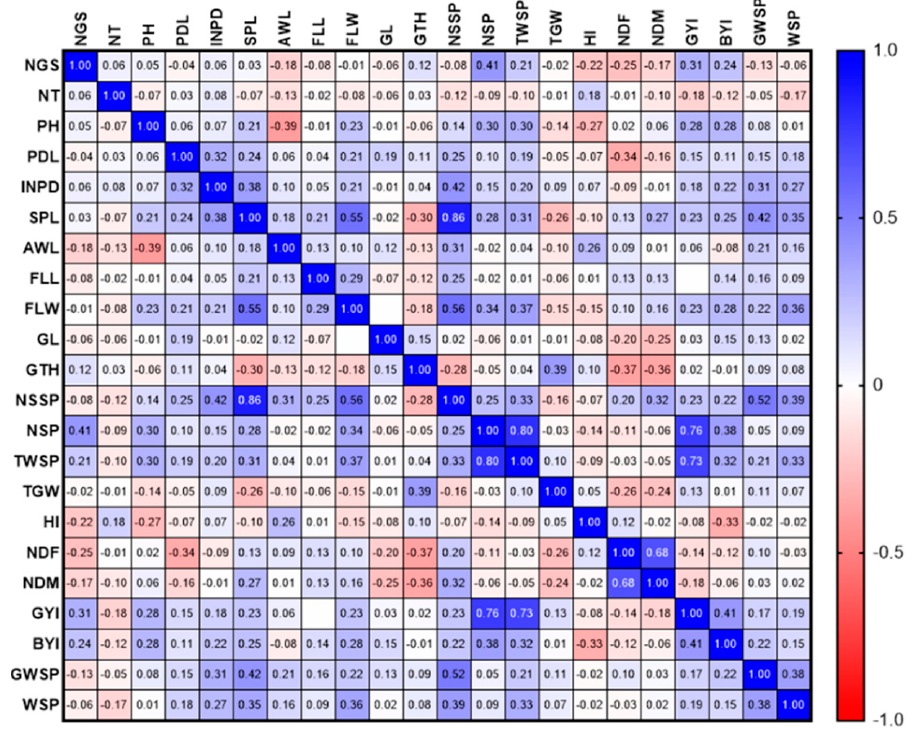
Figure 2. Correlation of study traits in F8 wheat lines resulting from Gonbad × Zagros in 2020.